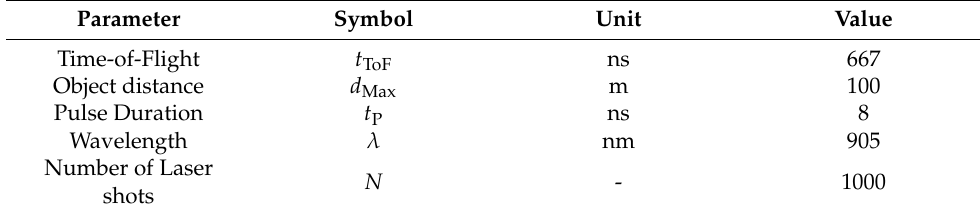
Figure 3. SNR for a single pixel SPAD and APD detector for a distance of 100 m and N = 1000 accumulations. ( a ) SNR values for APD [21] (Table 3). ( b ) Achievable SNR for a SPAD detector in single photon mode with parameters according to Table 1 and N SPAD = 1. SNR = 3 drawn as red contour for η PDE = 0.2 (solid line), η PDE = 0.05 (dashed line) and η PDE = 0.005 (dot-dashed line). Table 2. Common parameters for ranging